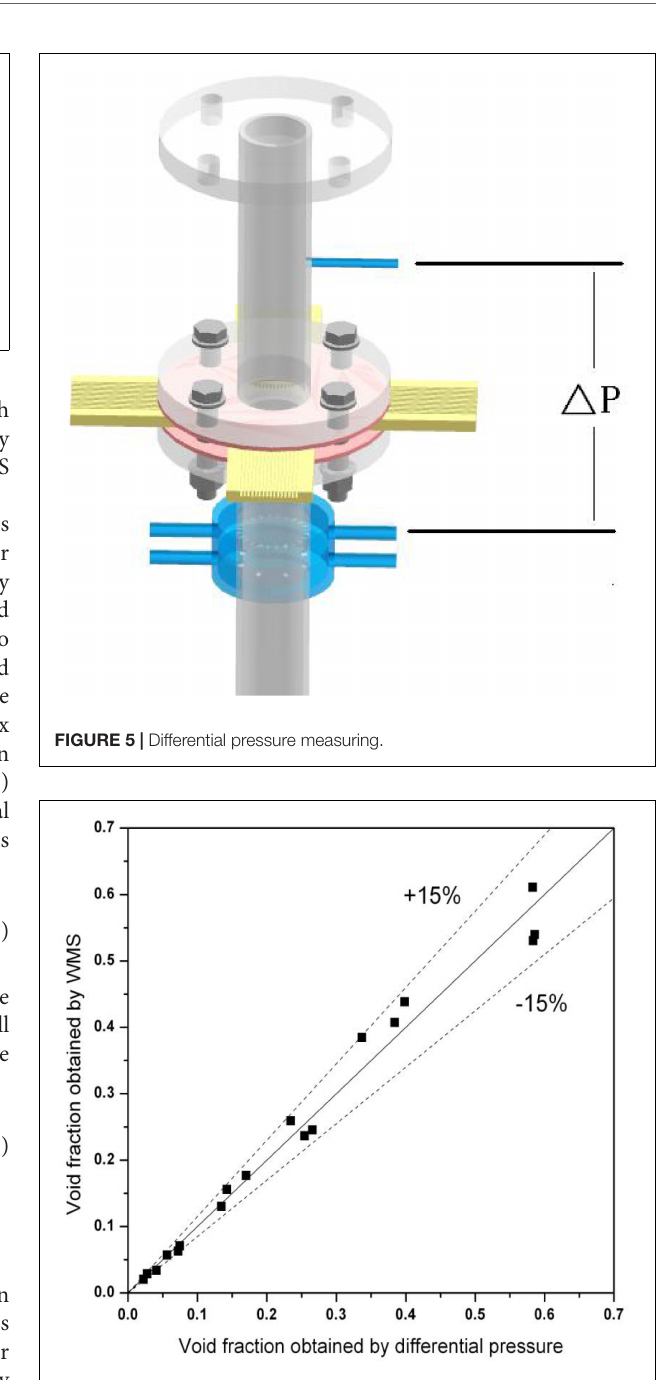
FIGURE 6 | Comparison result of void fraction